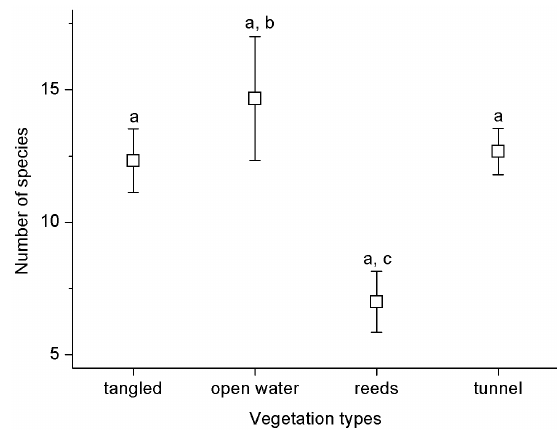
Figure 1. Number of Cladocera species by vegetation type.